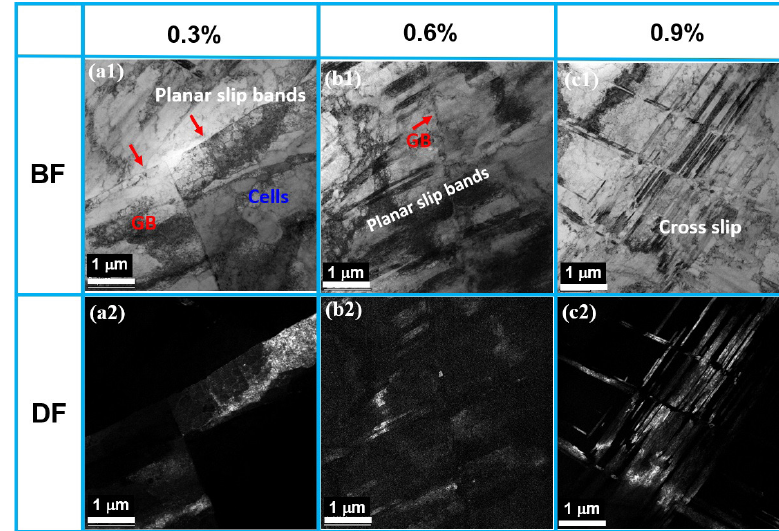
= 0.3%; (b1) and (b2) 0.6%; (c1) and (c2) t